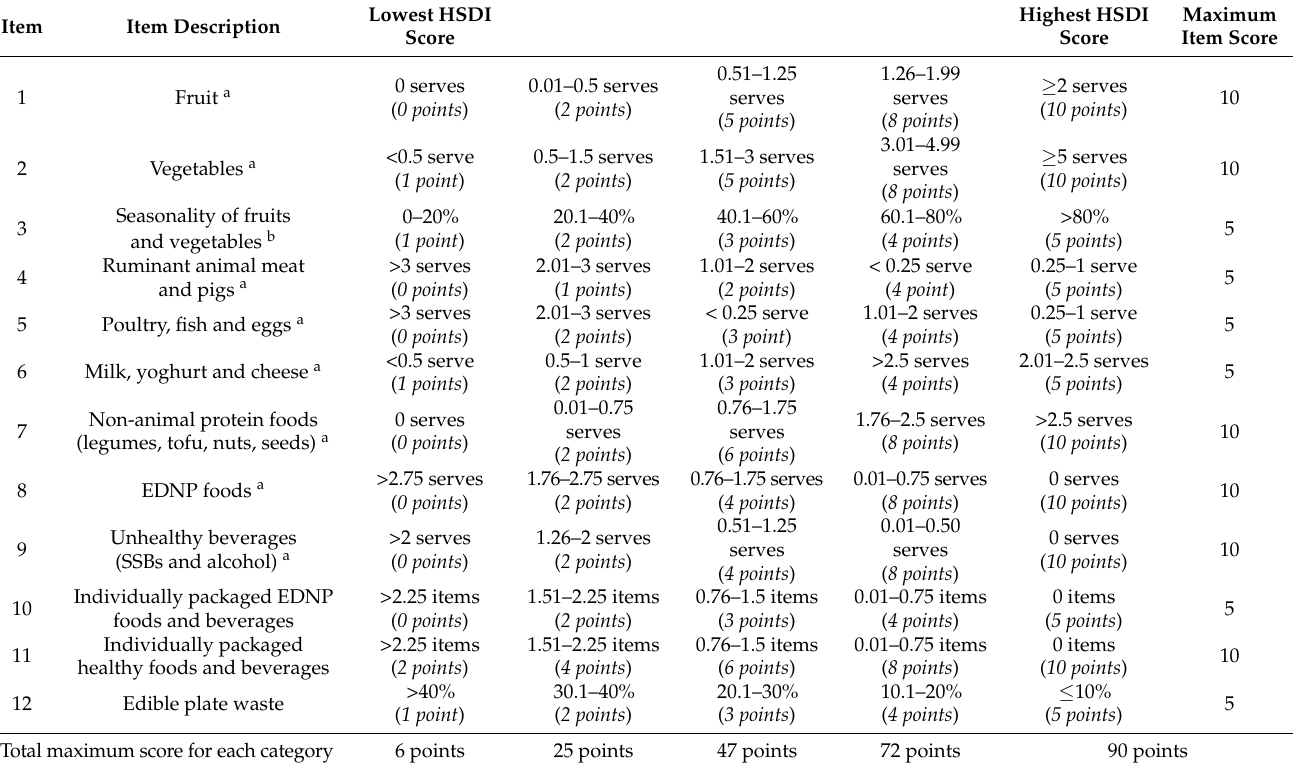
Table 1. Components of the Healthy and Sustainable Diet Index, in ascending order of alignment with a H&S diet (maximum score of 90)